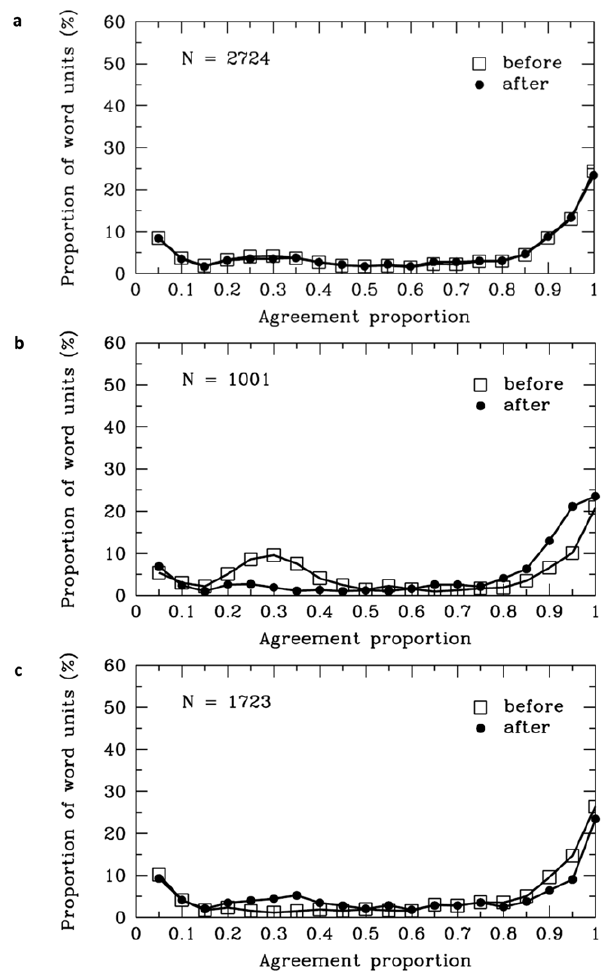
Figure 1. Global analyses. Frequency distribution of agreement proportions for word boundaries before (open squares) and after (filled circles) the SWU (a: total SWU; b: total SWU of function words; c: total SWU of content words). The y-axis represents the proportion of total SWU in the classes. The number of SWU is also displayed in each panel of the figure.